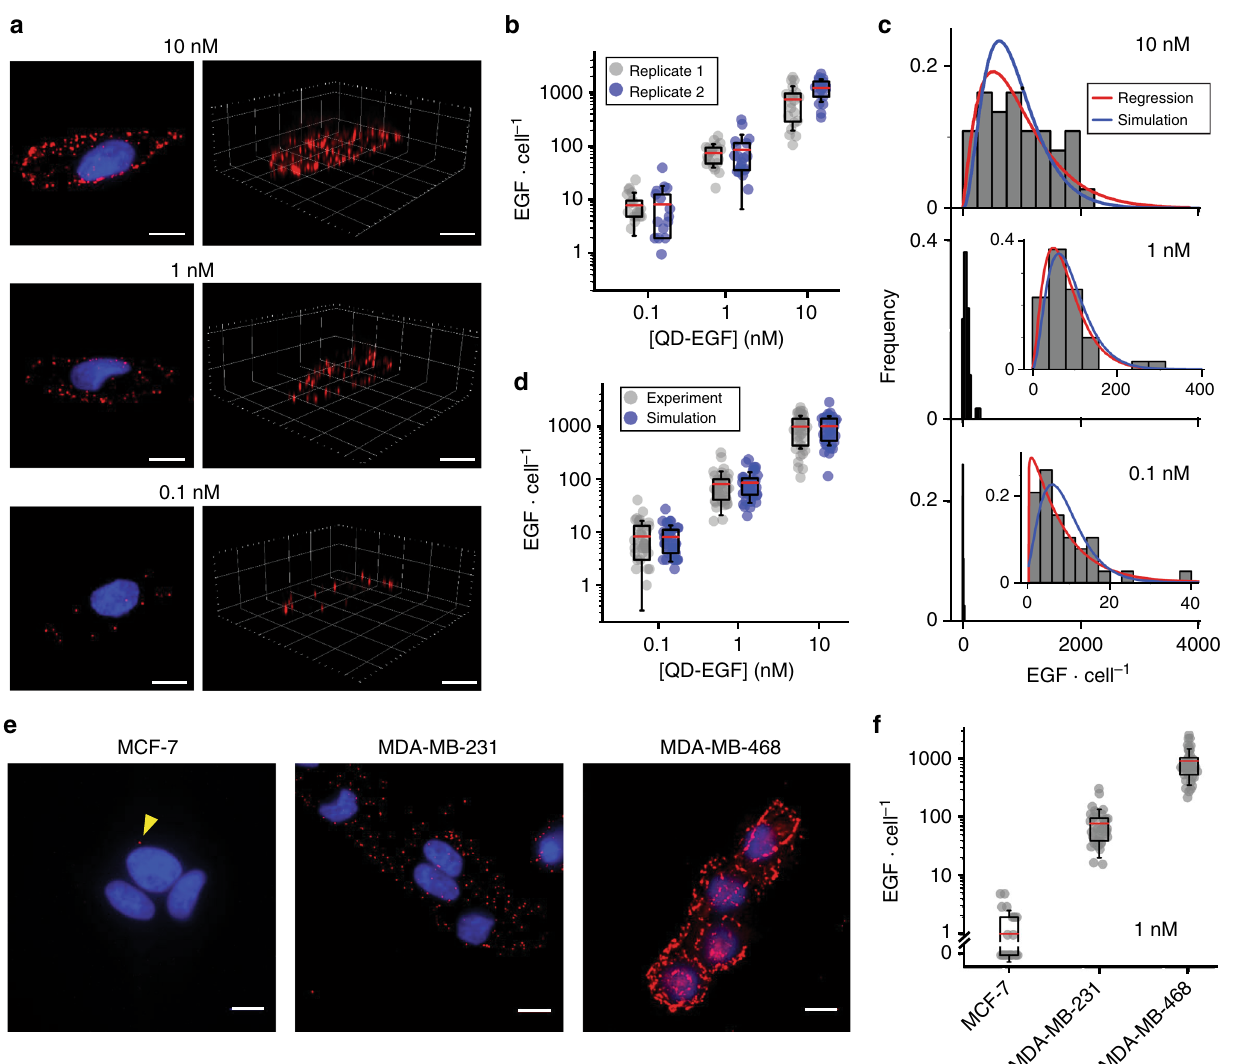
Fig. 4 Counting and simulating growth factor binding. a Representative z-projections of maximum intensity (left) and three-dimensional (3D) images (right) of cells treated with indicated quantum dot-epidermal growth factor (QD-EGF) concentration for 5 min on ice. b Number of QD-EGF bound per cell at indicated QD-EGF concentrations, showing two independent replicates with N ≥ 17 cells for each condition. c Distributions show the number of EGF per cell measured experimentally at the indicated QD-EGF concentration. Maximum likelihood estimation regressions of gamma distributions are shown as red lines and simulation results are shown as blue lines. For regression, p = 0.79, 0.88, and 0.85 for 0.1, 1, and 10 nM QD-EGF concentrations, respectively. For simulation, p = 0.24, 0.49, and 0.67 for 0.1, 1, and 10 nM QD-EGF concentrations, respectively. All p values were calculated using χ 2 tests. d EGF per cell is shown as experimental results (gray) and simulation results (blue) across different concentrations. Simulation results in d were obtained by sampling cells from the EGFR number gamma distribution (see Methods). e Representative z-projections of maximum intensity of breast cancer cell lines MCF-7, MDA- MB-231, and MDA-MB-468 in order of increasing EGFR expression. Cells were treated with 1 nM QD-EGF for 5 min on ice. Yellow arrow indicates a single QD-EGF bound to an MCF-7 cell. f Number of QD-EGF bound per cell for conditions in e with N ≥ 40 cells for each condition. QDs are shown in red and nuclei are blue. In a , e , QDs are shown in red and nuclei are blue; scale bars, 10 µ m. In b , d , f , the box indicates 25/75th percentile; red lines are means; whiskers are